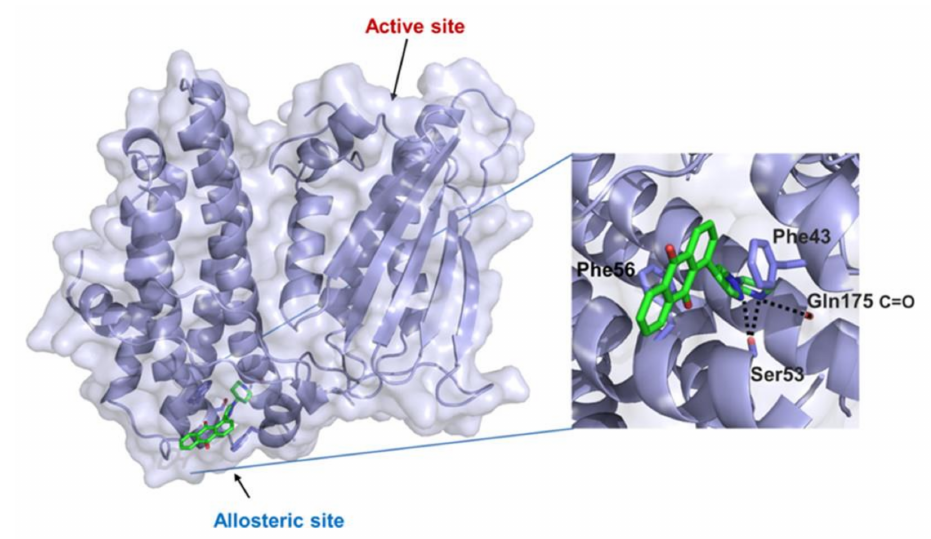
Figure 67. Putative binding mode of compound 61 with the lipoamide allosteric site of PDK4 kinase crystal structure [74].